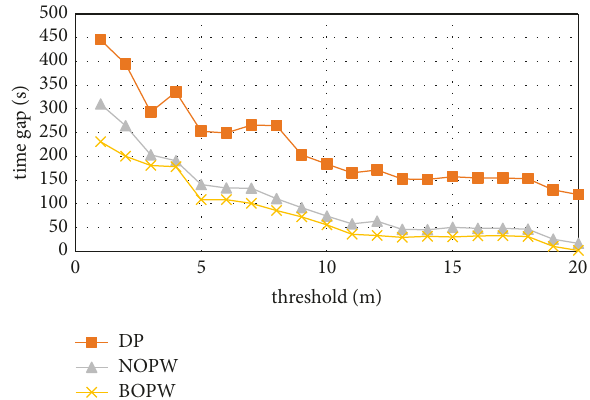
Figure 15: Relationship between threshold and compression time gap of SW DP, NOPW, and BOPW